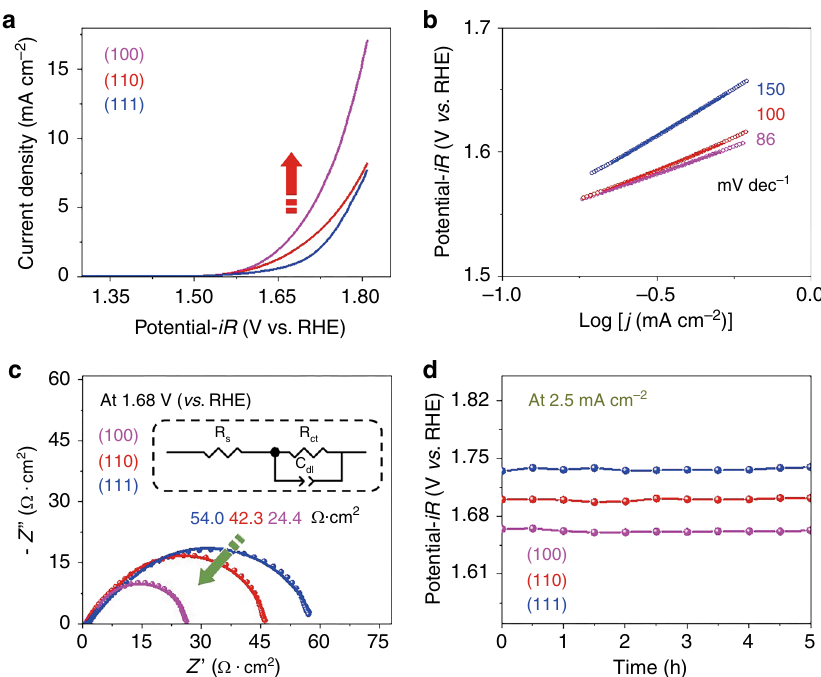
Fig. 2 OER activity for PBSCF thin fi lms with different orientation. a LSV curves; b Tafel plots; c Nyquist plots of OER on PBSCF thin- fi lm electrodes in 1 M KOH at 1.68 V (vs. RHE; solid dots are the raw data, solid lines are the fi tted results, and the inset fi gure shows the electrical equivalent circuit); and d Chronopotentiometry curves at a constant current density of 2.5 mA cm − 2